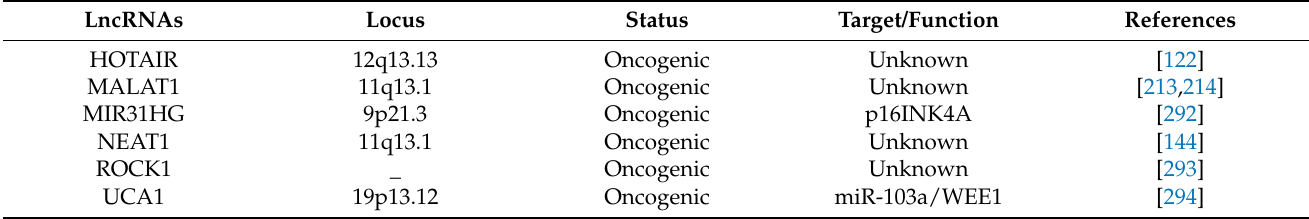
Table 5. LncRNAs involved in proliferation, invasion, apoptosis, migration, metastasis, and drug resistance in vulvar cancers. LncRNAs